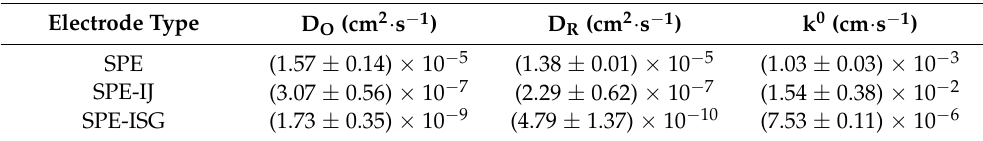
Figure 4 . Anodic and cathodic peak currents as a function of the square root of the scan rate. Values are averages from the three cycles and error bars are the standard deviation: ( A ) SPE, ( B ) IJ-modified SPE and ( C ) ISG-modified SPE. Table 2. Diffusion coefficients and electron transfer rate constants for the three electrode types used. Values are averages of all cycles and errors are the standard deviation.